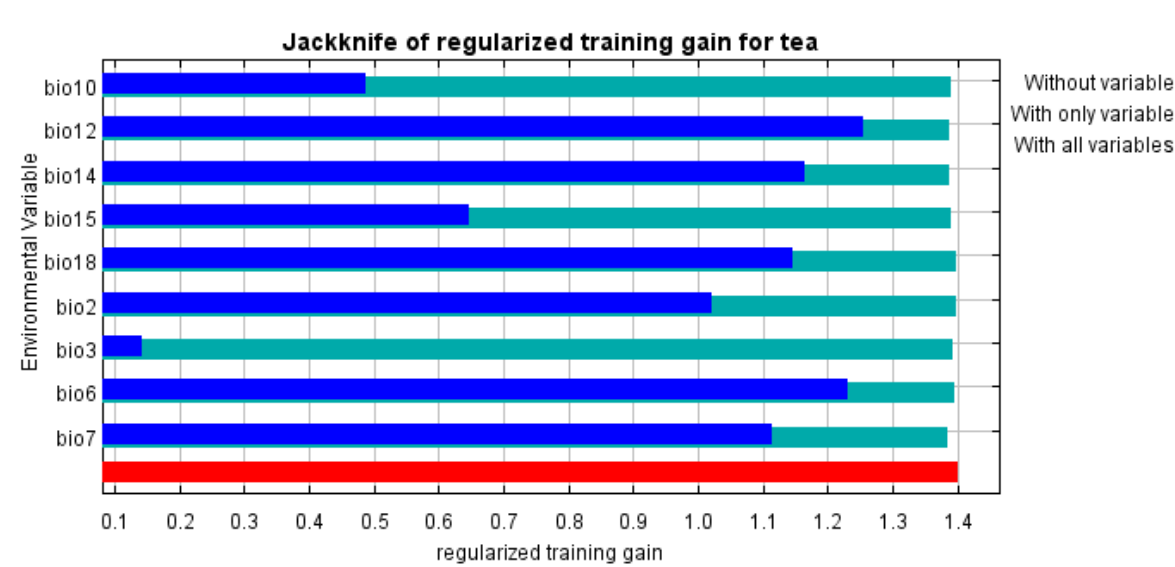
Figure 3. Results of Jackknife evaluations of the relative importance of predictor variables and their percentage contribution in Maxent model for tea species in China. Table 2. Percentage contribution and permutation importance of the predictor variables to the MaxEnt model.